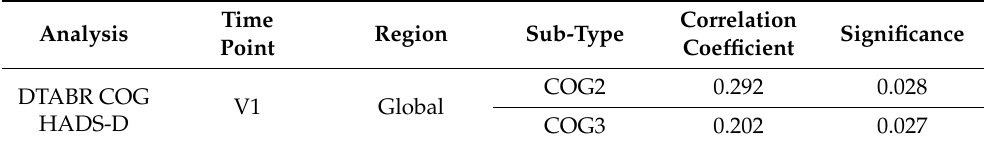
Table 3. Significant correlations at V1.